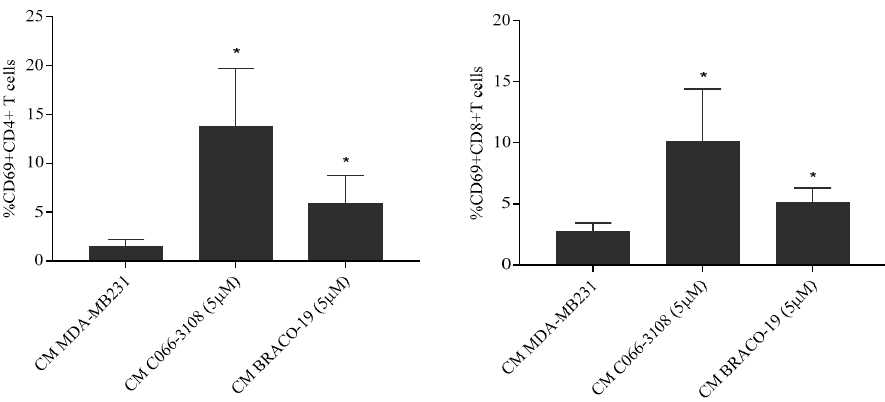
Figure 6. T cell activation by G4 ligands. CM obtained from the experimental conditions indicated